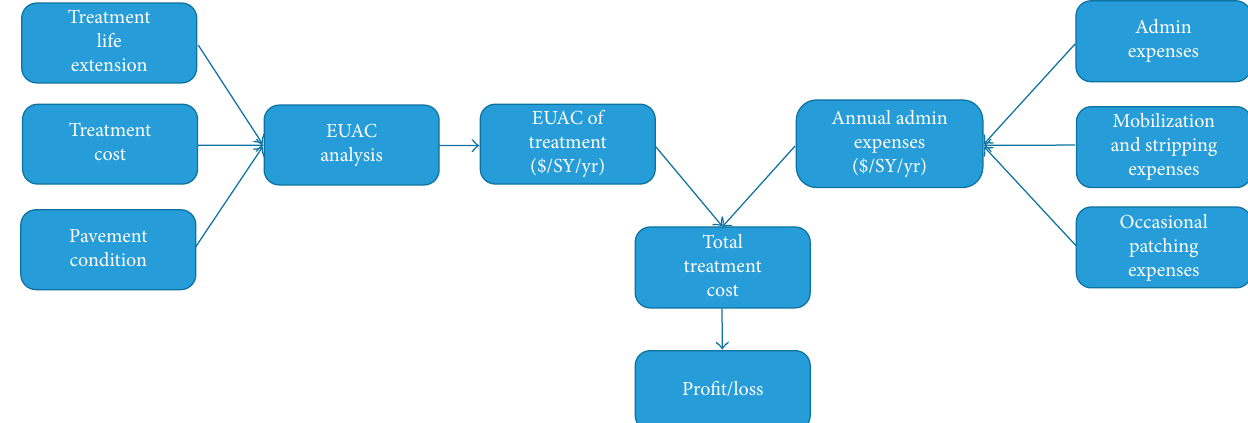
Figure 2: PMAR cost